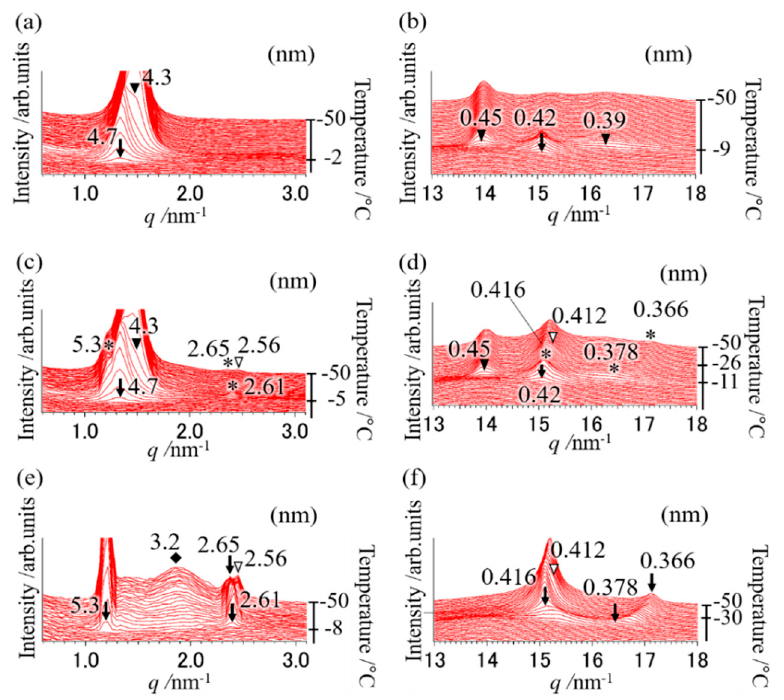
Figure 1. Synchrotron radiation time-resolved X-ray diffraction (SR-TXRD) results at the cooling rate of ( a , b ) 20 °C min − 1 , ( c , d ) 25 °C min − 1 , and ( e , f ) 35 °C min − 1 with a binary mixture of OPO/POP = 5/5. The x-axes show q value ( q (cid:3404) 4(cid:2024) (cid:3401) sin(cid:4666)(cid:2016)(cid:4667) /(cid:2019) ). The left y-axes show diffraction intensity. The right y- axes show temperature. ( a , c , e ) indicate magnification of small-angle pattern. ( b , d , f ) indicate magnification of wide-angle pattern. The arrows and asterisks are derived from POP crystals (4.7 and 0.42 nm: α form, 5.3, 0.416, etc., nm: sub- α form). The closed triangles are derived from β -2 MC. The